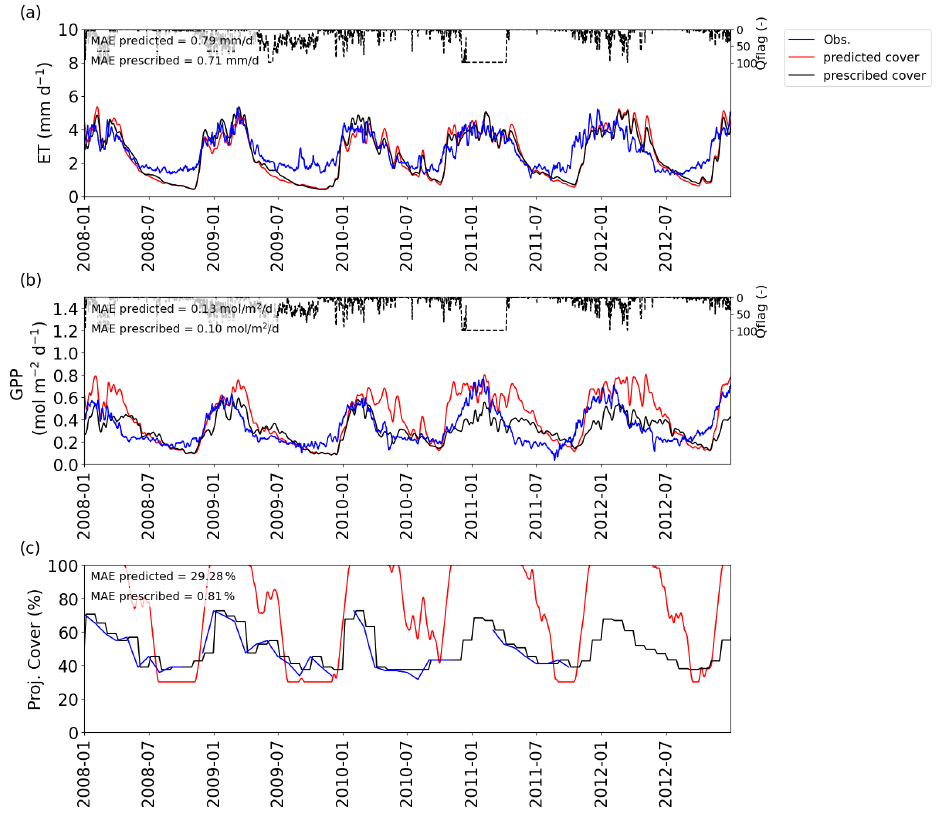
Figure 7. Comparison between the VOM with prescribed and predicted vegetation cover for Daly River for 2008–2012 (as a subset from 1980 to 2017), for (a) ET and (b) GPP and (c) projective cover, with model results obtained by the predicted cover in red and the prescribed cover in black. The flux tower observations and fPAR-derived projective cover are shown in blue. Daily average quality flags for the flux tower observations are added on top and range from 0 (no missing values) to 100 (completely gap-filled). The time series for ET and GPP are all smoothed with a moving average with a window of